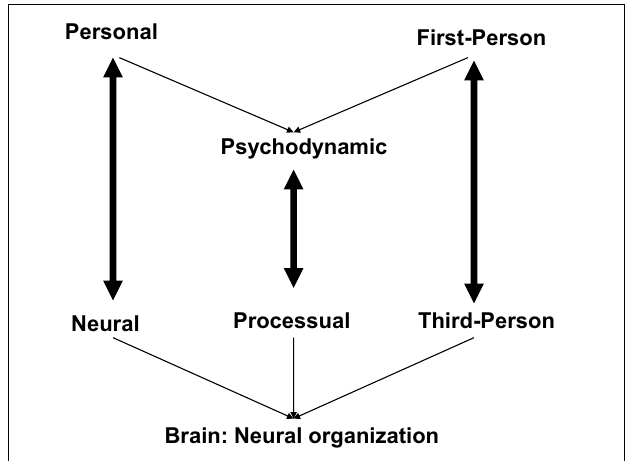
FIGURE 2 | Different levels and the translation